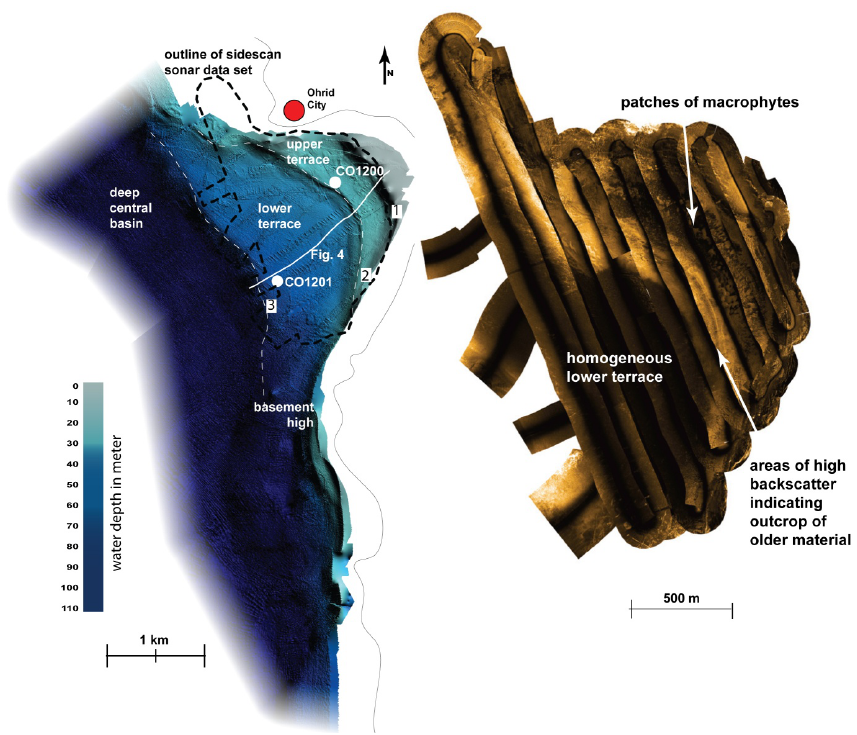
Fig. 3. Bathymetric map of Ohrid Bay (left) with major morphological features such as upper and lower terrace, deep central basin, three morphological steps (1, 2, 3 at water depth 15m, 35m, and 60m, respectively). Locations of sediment cores (Co1200, Co1201) are marked as white dots. Sidescan sonar mosaic (right) images the upper portion of Ohrid Bay. Bright colors are areas of high backscatter. The outline of the sidescan sonar mosaic is shown as dashed line on the bathymetry. Note the different scales for each map. See Fig. 2 for location.